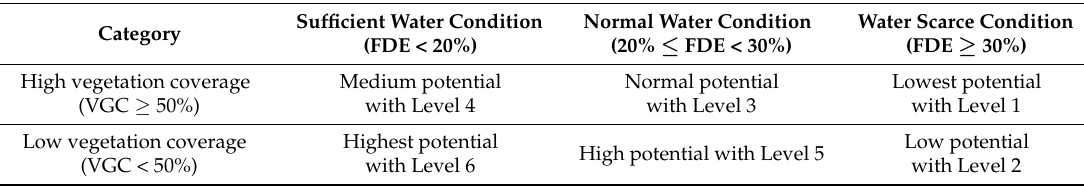
Table 2. The classification standard for the vegetation recovery potential assessment based on the FDE and vegetation coverage (VGC)